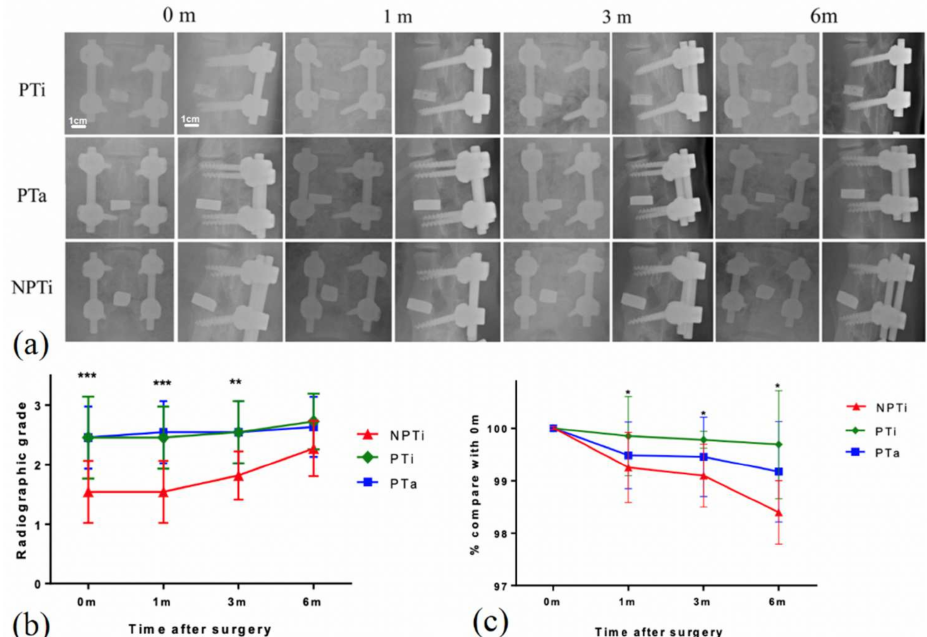
Figure 7. ( a ) Radiographic exam of every time point in porcine lumbar interbody fusion model of nonporous titanium (NPTi), 60% porous titanium (PTi), and porous tantalum (PTa) cages. ( b ) Ra- diographic grades and ( c ) fusion segment lengths of NPTi, PTi, and PTa cages at time of operation (op, 0 m), 1 month post-surgery (1 m), 3 months post-surgery (3 m), and 6 month post-surgery (6 m). * p < 0.05, ** p < 0.01, *** p <